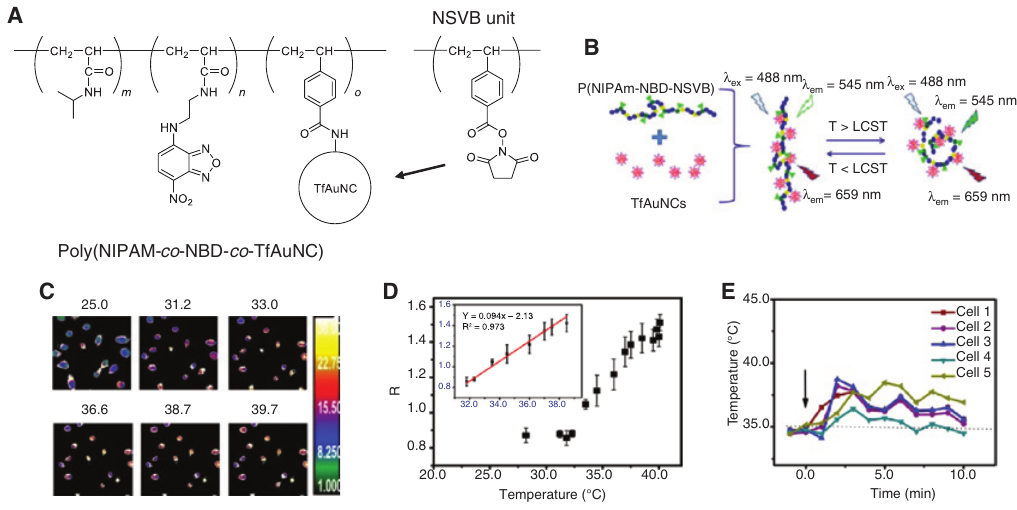
Figure 11: Intracellular thermometry of living HeLa cells using poly(NIPAM- co -NBD- co -TfAuNC). (A) Chemical structures of poly(NIPAM- co -NBD- co -TfAuNC) and NSVB units. (B) Schematic representation of the function of poly(NIPAM- co -NBD- co -